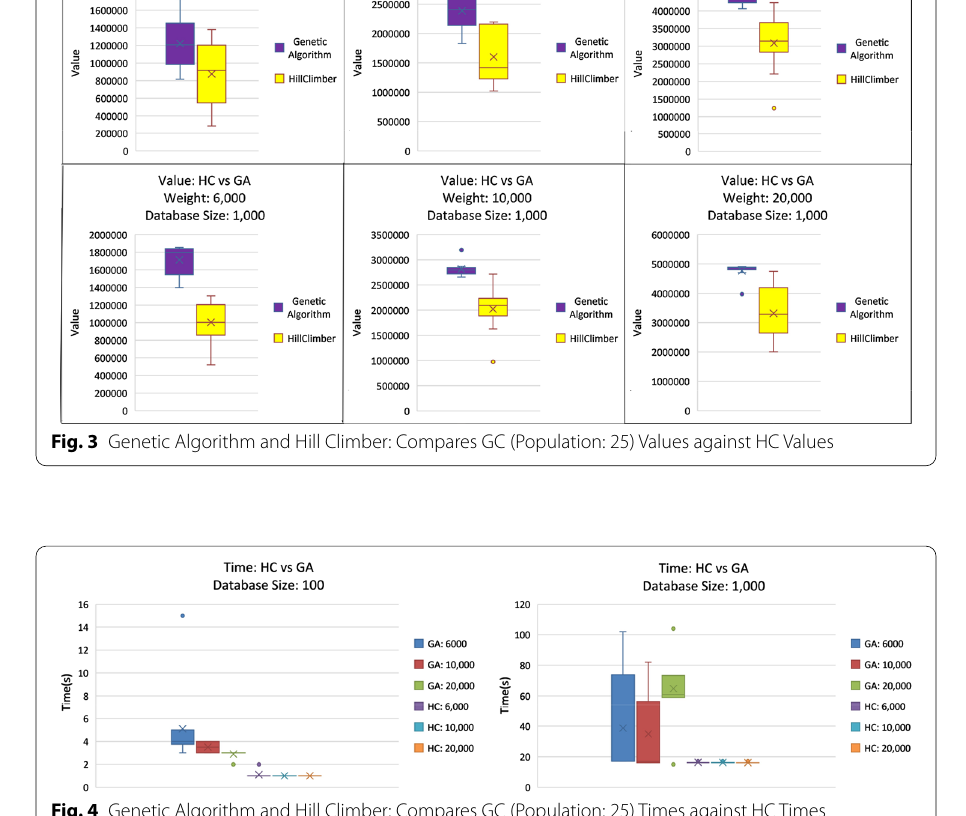
Table 5 Number of Solutions Found for HC and GA algorithms (Population: 10) Algorithm GA HC GA HC GA HC Weight Limit 6000 6000 10,000 10,000 20,000 20,000 Average Number of Solu- 793 2 11034 2 72751 4 tions Found: 100 Mission Database Average Number of 4411 4 91003 4 388705 Solutions Found: 1000 Missions Database